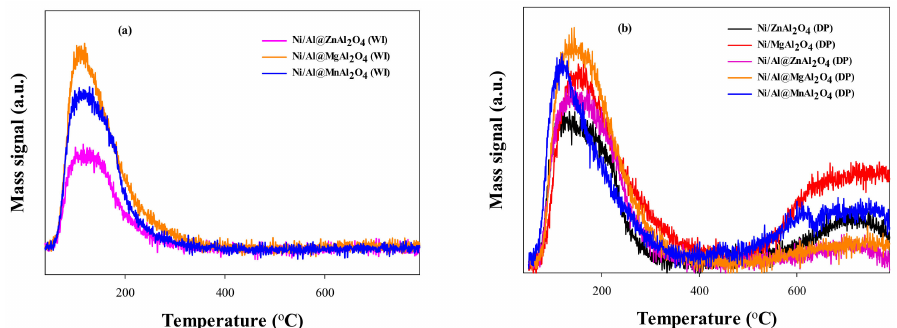
Figure 1. Temperature-programmed desorption of CO 2 (CO 2 -TPD) profiles of supported Ni catalysts